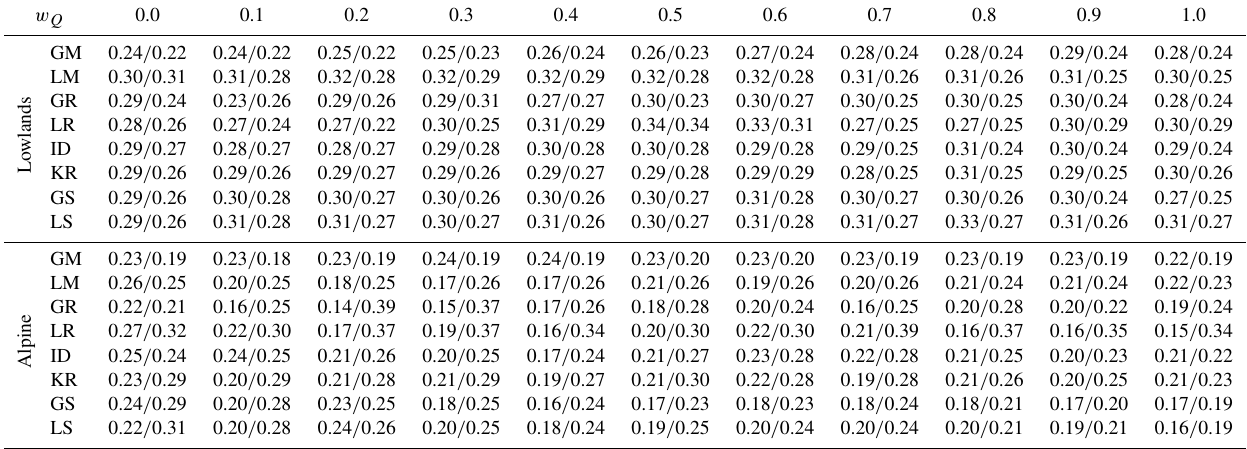
Table 4. Scatter (difference of 75% and 25% quantiles of model efficiency) of the leave-one-out soil moisture correlation (Eq. 8) obtained by eight groups of parameter transfer methods and 11 calibration weights for lowland (94) and alpine (119) catchments in the